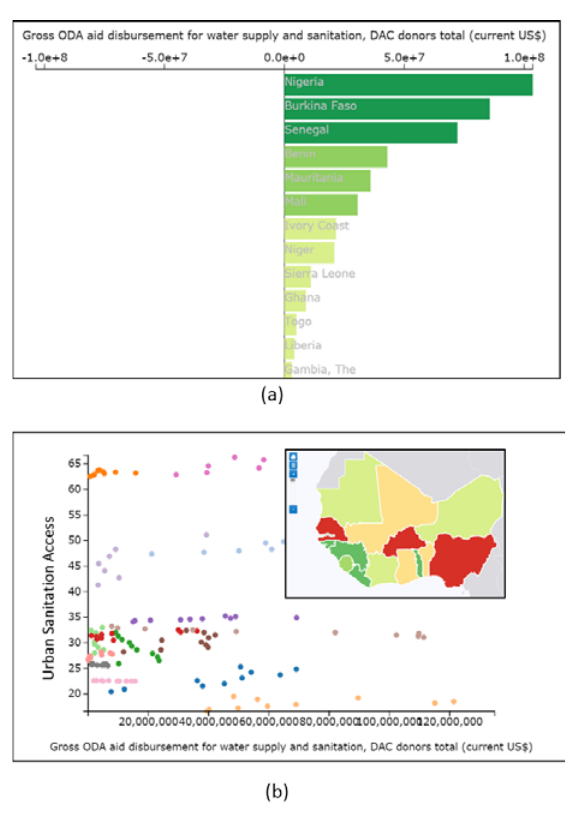
Figure 8. a) Change in values or end value minus starting